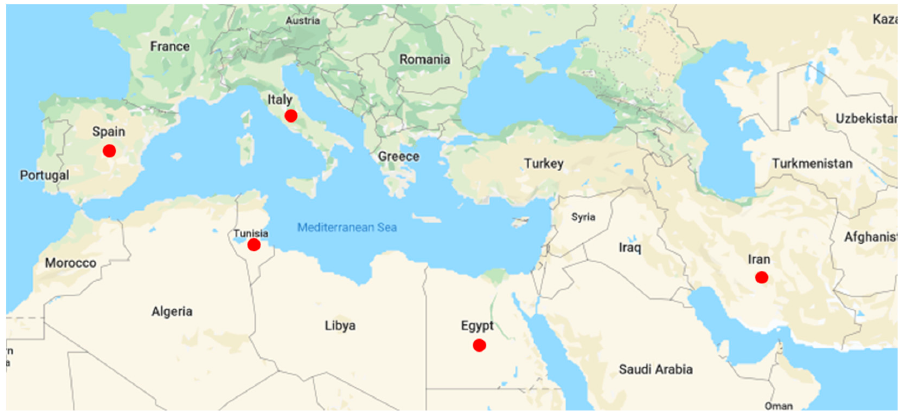
Figure 1. Countries of origin (red dots) of the Fusarium verticillioides strains used in this study. Map downloaded from www.google.com/maps and modified by the authors.